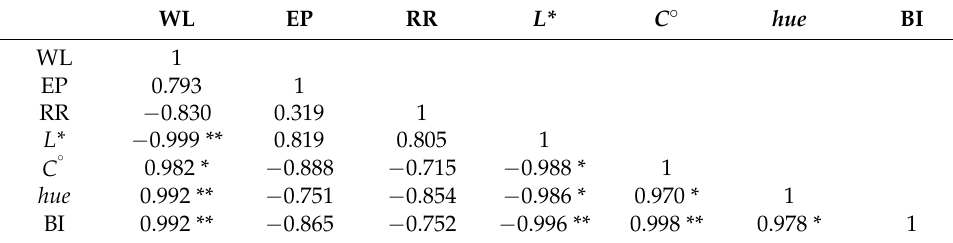
Table 4. Pearson’s correlation coefficients between the measured parameters of Agaricus bisporus during the storage